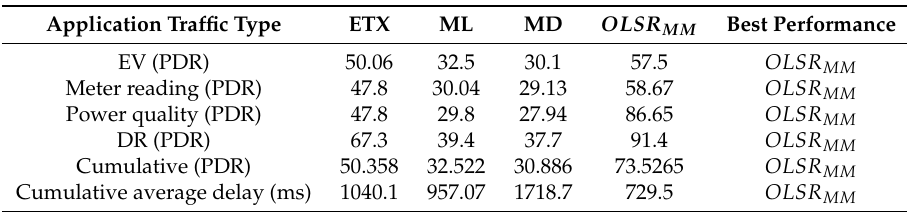
Table 5. Summary of the simulation results for the NAN grid